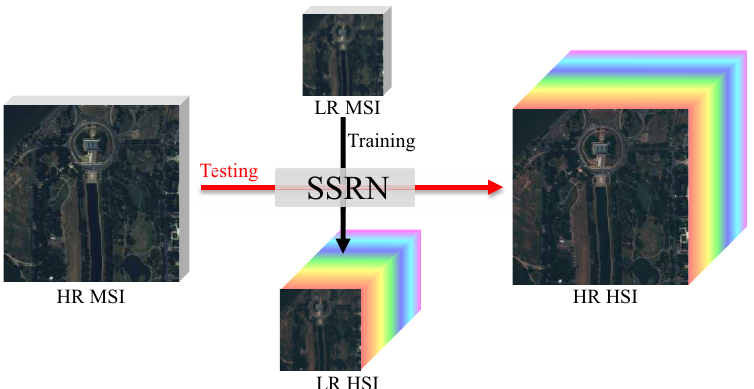
Figure 1. Illustration of the proposed spectral-spatial residual network (SSRN) framework. Firstly, a low spatial resolution (LR) multispectral image (MSI) and an LR hyperspectral image (HSI) are utilized to train the proposed SSRN to learn the pixel-wise spectral mapping. Then, the learned pixel-wise spectral mapping is exploited to estimate high spatial resolution (HR) HSIs from HR